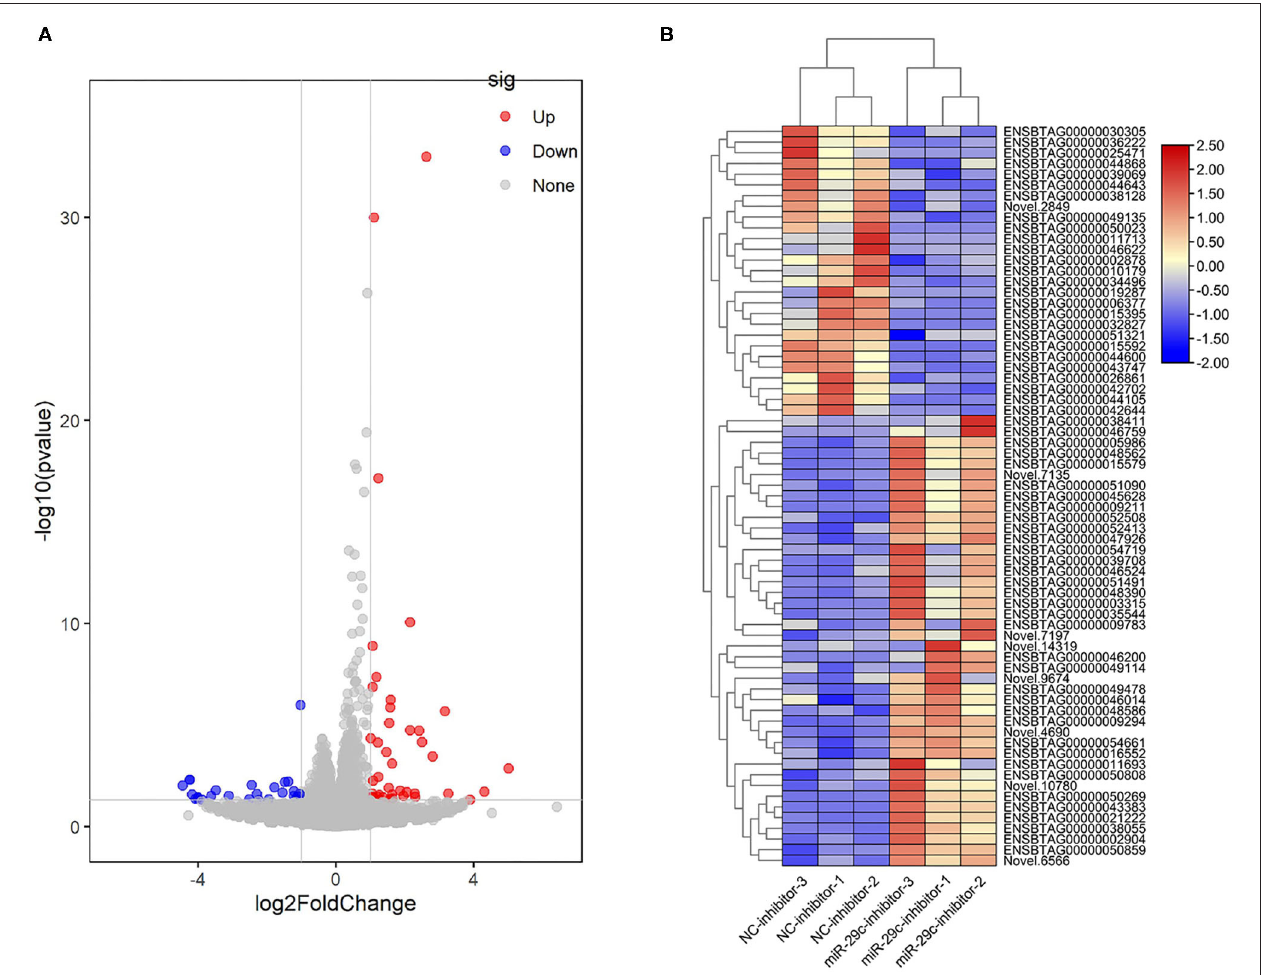
FIGURE 4 | Analysis of DEGs in miR-29c inhibitor and NC inhibitor groups. (A) Volcano map of genes expression between the miR-29c inhibitor and NC inhibitor groups. The red points represent up-regulated genes, and the blue points represent down-regulated genes with statistical significance. (B) Cluster heat map of DEGs between the miR-29c inhibitor and NC inhibitor